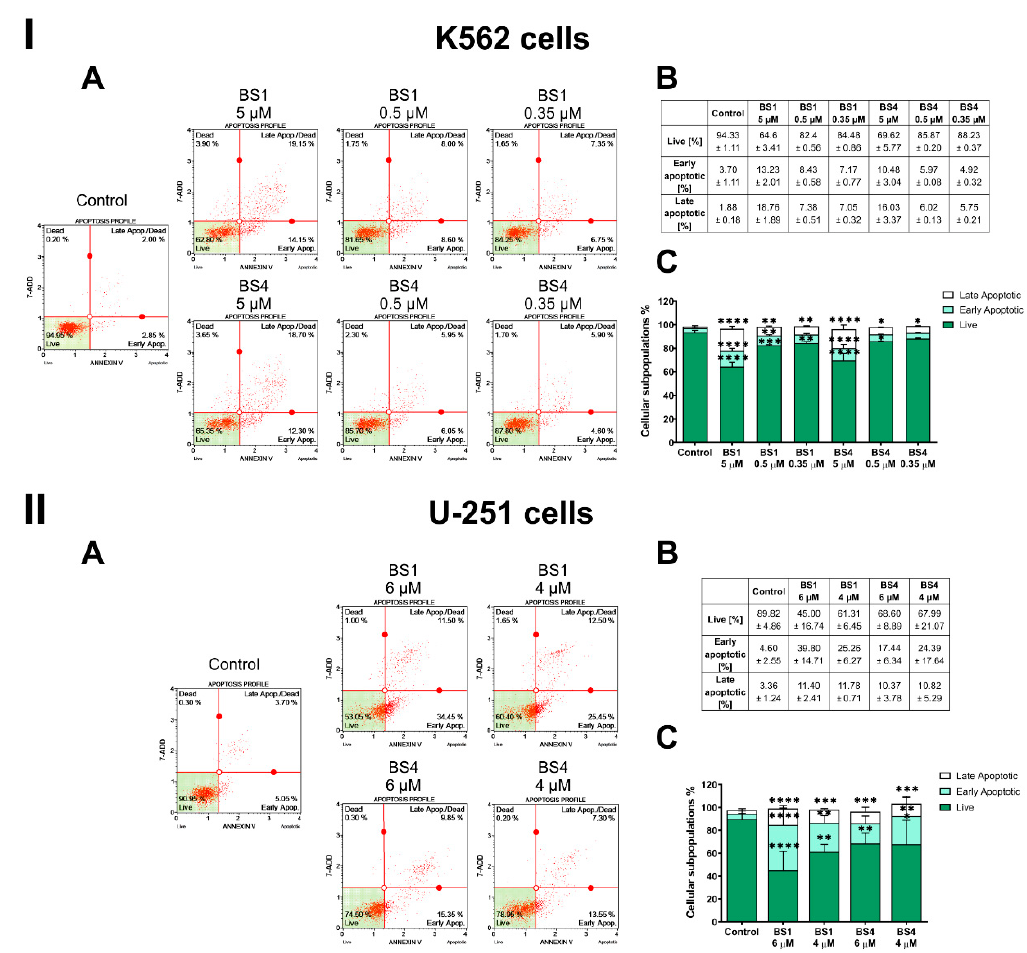
Figure 5. Assessment of the effect on the induction of apoptosis in the K562 ( I ) and U-251 ( II ) cells after a 48 h incubation with the tested compounds ( BS1 , BS4 ) at various concentrations. The representative histograms from one of several independent experiments include the percentage of live and apoptotic cells ( A ). The table contains the mean ± SD percentage of the live, early and late apoptotic cells from all of conducted experiments ( B ). Data chart with the statistical analysis using a one-way ANOVA with Bonferroni’s post-hoc test: * p < 0.05, ** p < 0.01, *** p < 0.001, **** p < 0.0001 compared to the untreated cells (control) ( C ).